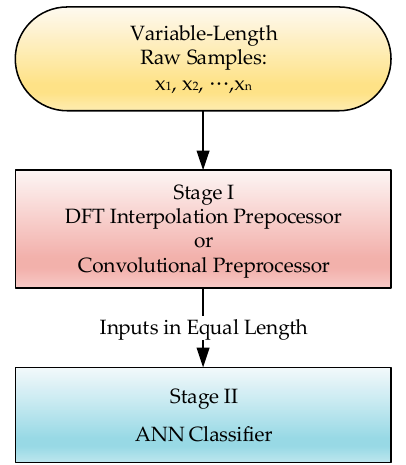
Figure 3. A two-stage scheme to complete the ANN model for evaluation.